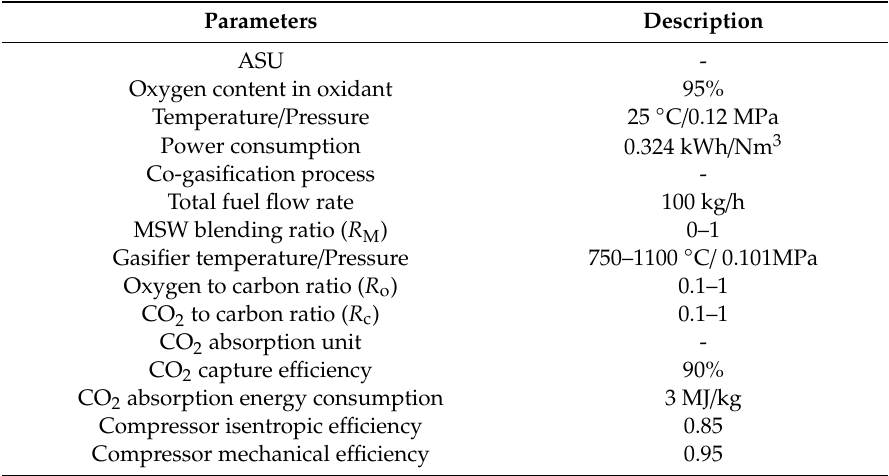
Table 4. The operating parameters of co-gasification system of MSW and coal in CO 2 / O 2